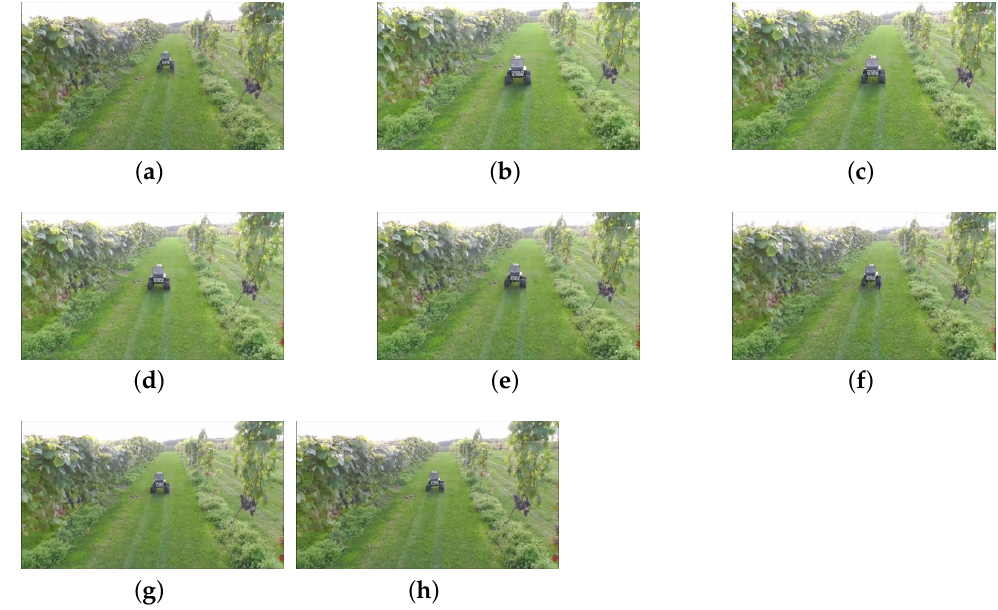
Figure 11. ( a – h ) shows the successive snapshots of autonomous robot navigation in the center of vineyard’s lane using the proposed algorithm. The video of the experiment is provided in the supplementary